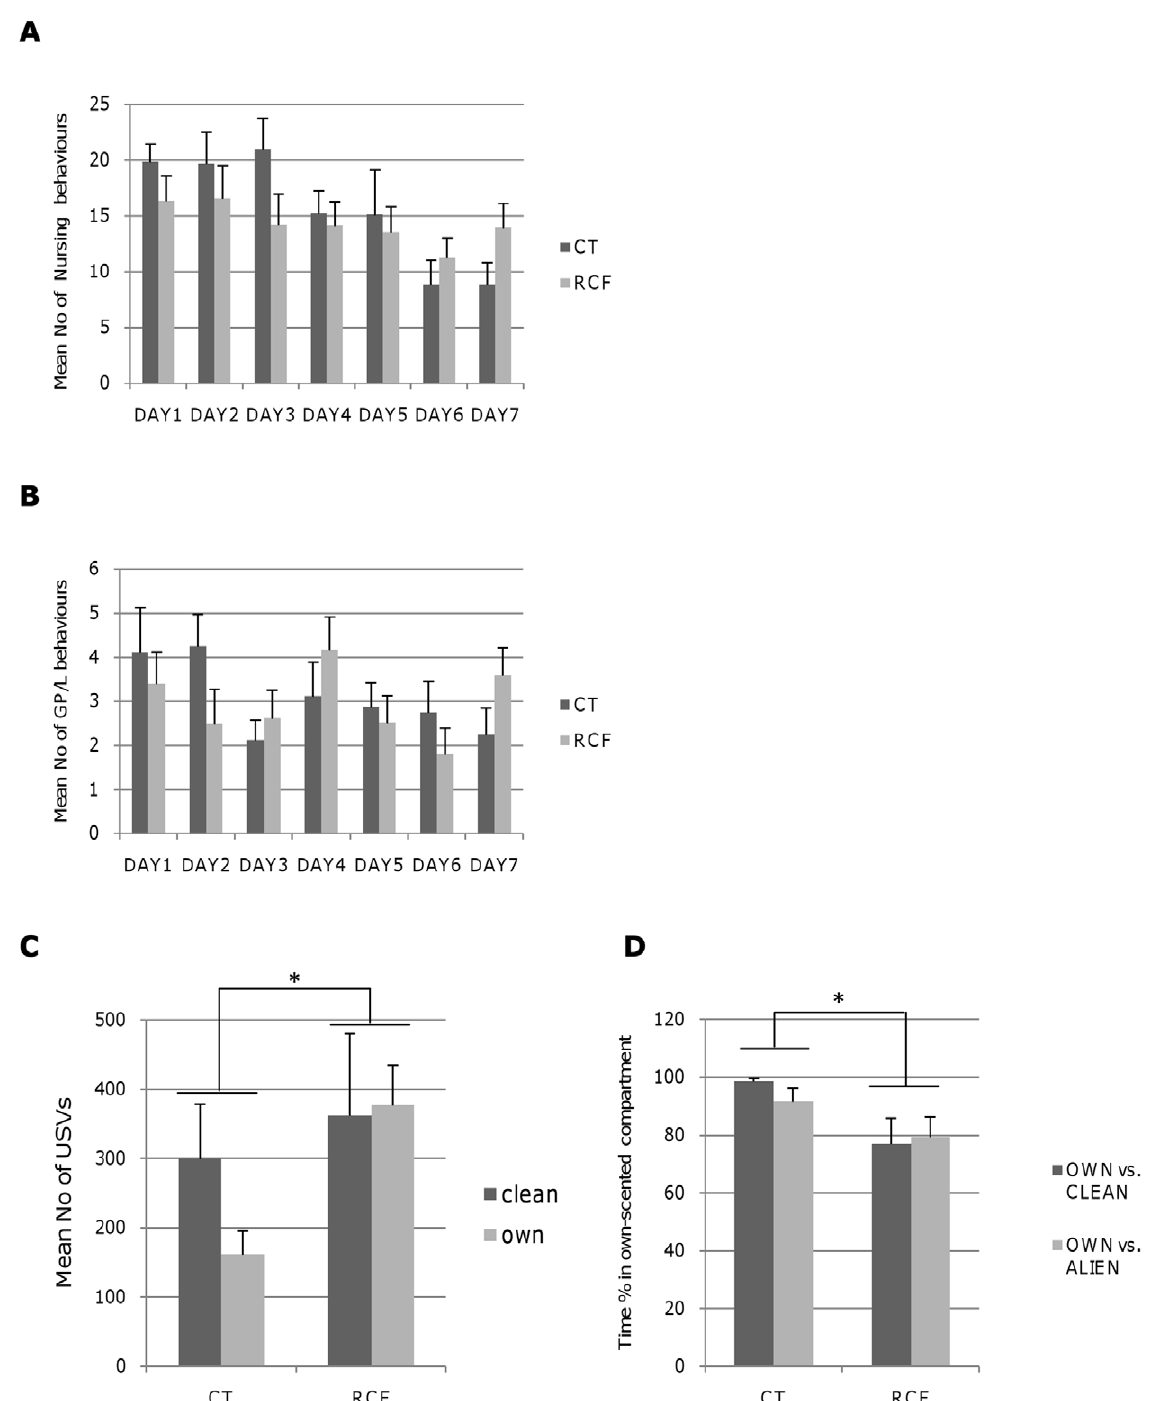
Figure 2. Maternal care and offspring behavioural indices in standard rearing (CT) vs. repeated cross-fostering (RCF) conditions. Sum of 2 daily observations of maternal behaviour: A ) nursing behaviour, encompassing ‘arch-back’ + ‘blanket’ postures, and B ) grooming/licking (GP/ L) behaviour towards adoptive (RCF n=10) and own (CT n=8) litter, measured during PND1–PND7. Nursing decreased significantly in time, and was comparable in RCF and CT pups across the PND1–PND7 time span. Grooming/licking (GP/L) did not vary significantly in time, and RCF and CT pups received comparable GP/L (see Methods and Results sections for details). Pups’ behaviour: C ) Mean number of ultrasonic vocalisations (USVs) emitted by 8-day old RCF and CT pups. Pups were isolated and exposed for 5 9 to fresh clean bedding (clean) and own-cage bedding (own). ANOVA showed that the postnatal treatment (RCF vs. CT) yielded a significant effect (F 1,73 =4.24, p=0.04) while the condition (‘clean’ vs. ‘own’ bedding) did not exert a significant effect (F 1,73 =0.84, p=NS); there was no significant postnatal treatment-by-condition effect (F 1,71 =1.29, p=NS). D ) Percentage of time spent during 5 minutes by pups in a compartment containing own-cage vs. fresh clean bedding (own vs. clean), or own-cage vs. an alien dam’s bedding (own vs. alien dam). RCF pups spent less time in the compartment with own-cage bedding than controls in both conditions (F 1,64 =7.46, p , 0.01).